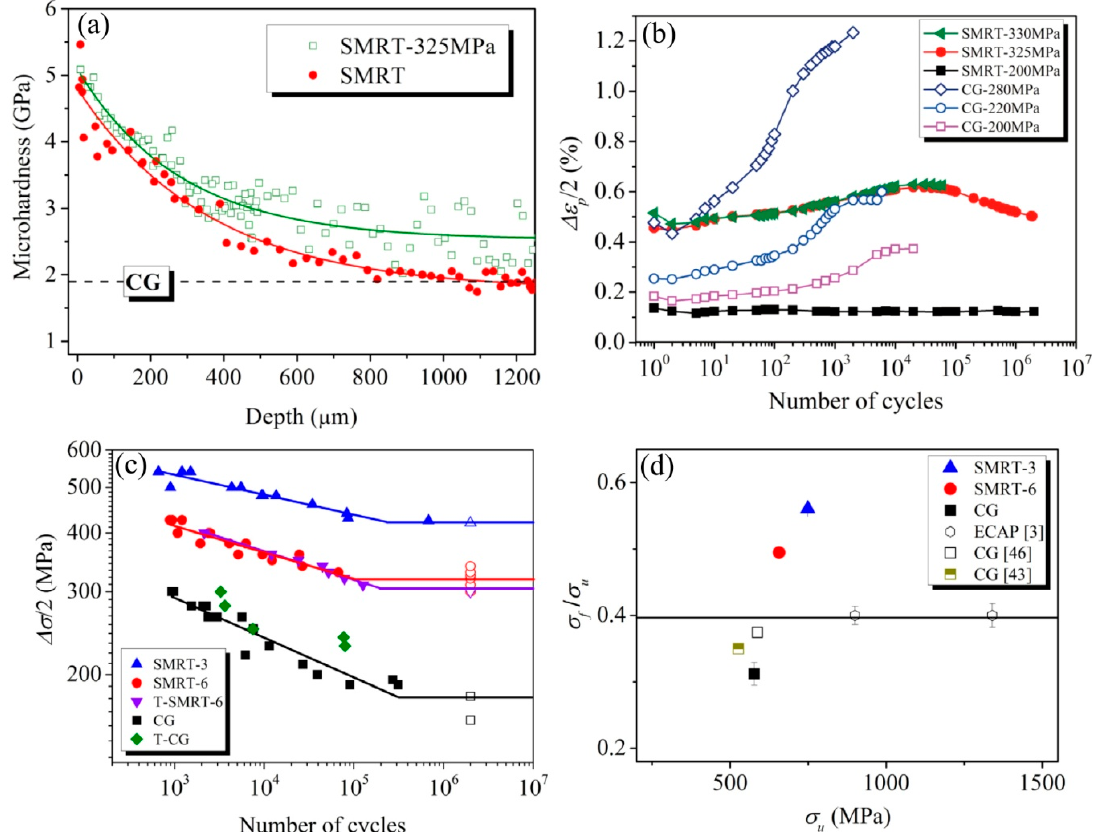
Figure 10. Fatigue behaviors of an AISI 316L stainless steel with gradient structure: ( a ) Distributions of microhardness along the depth for different samples; ( b ) Cyclic deformation curves of the CG and the gradient structured samples at different stress amplitudes as indicated; ( c ) S-N curves of different samples; ( d ) Correlation between the tensile strength and fatigue ratio (adapted from [49]).